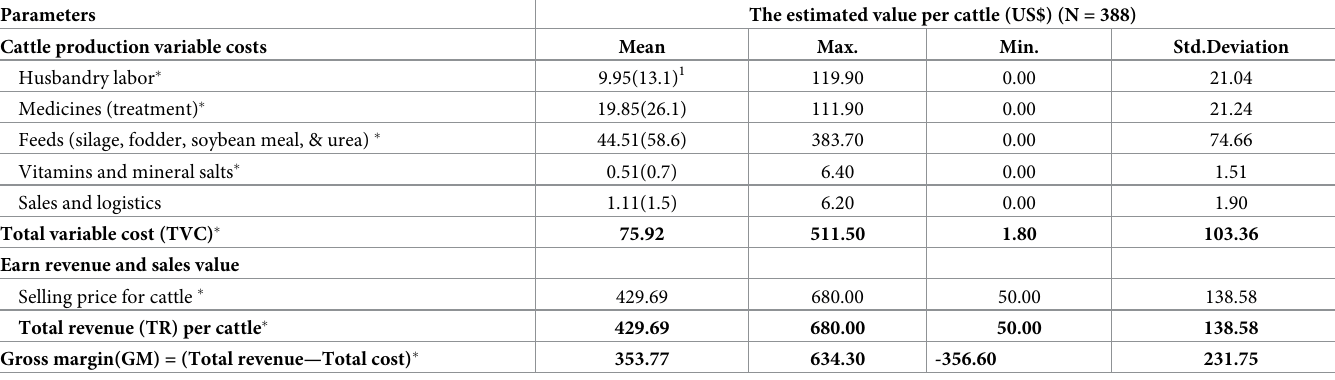
Table 5. The gross margin of beef cattle farming among smallholder beef cattle farmers (N = 388).